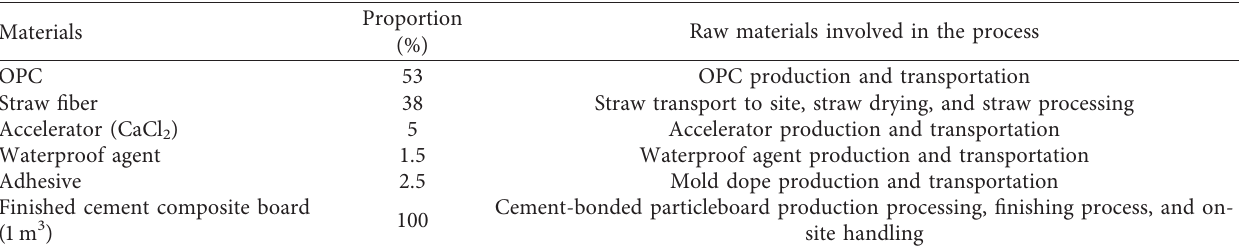
Table 5: Composition of straw cement-bonded particleboard and the process